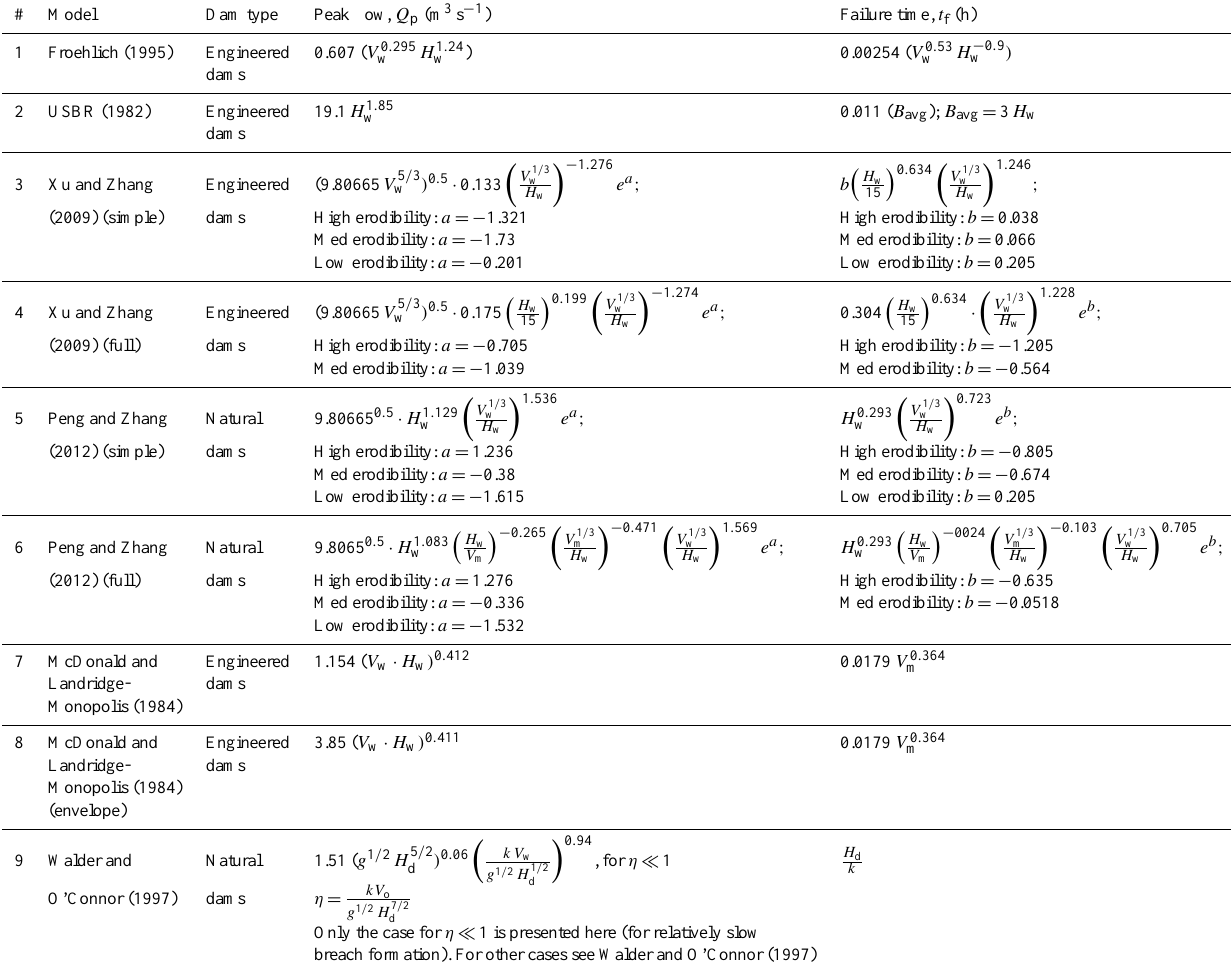
Table 1. Empirical equations for peak flow and failure time for dam-breach